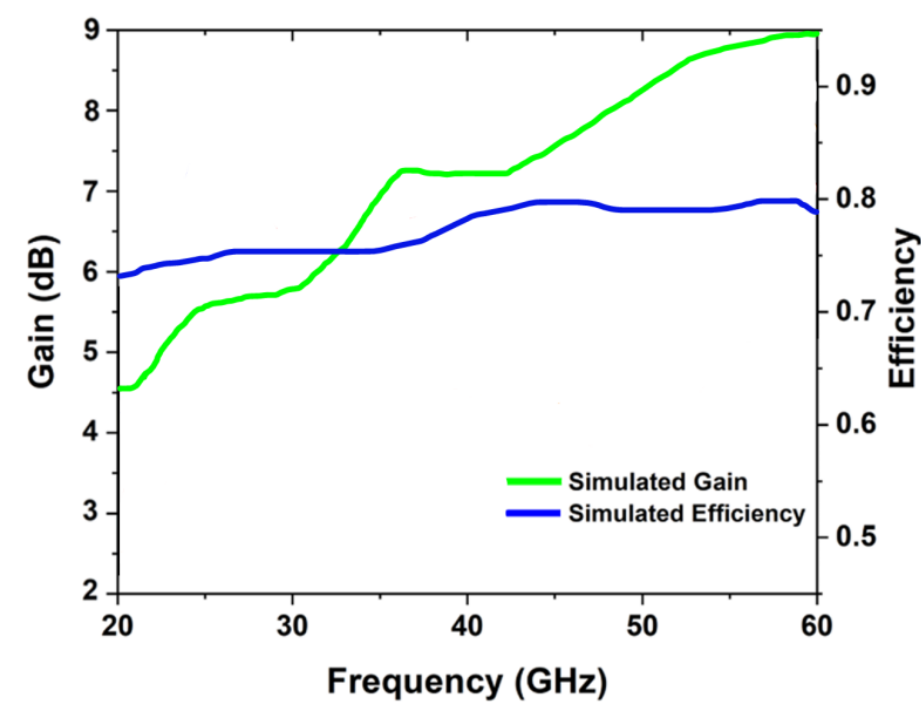
Figure 12. Efficiency and gain curves at operational frequency bands over phantoms.